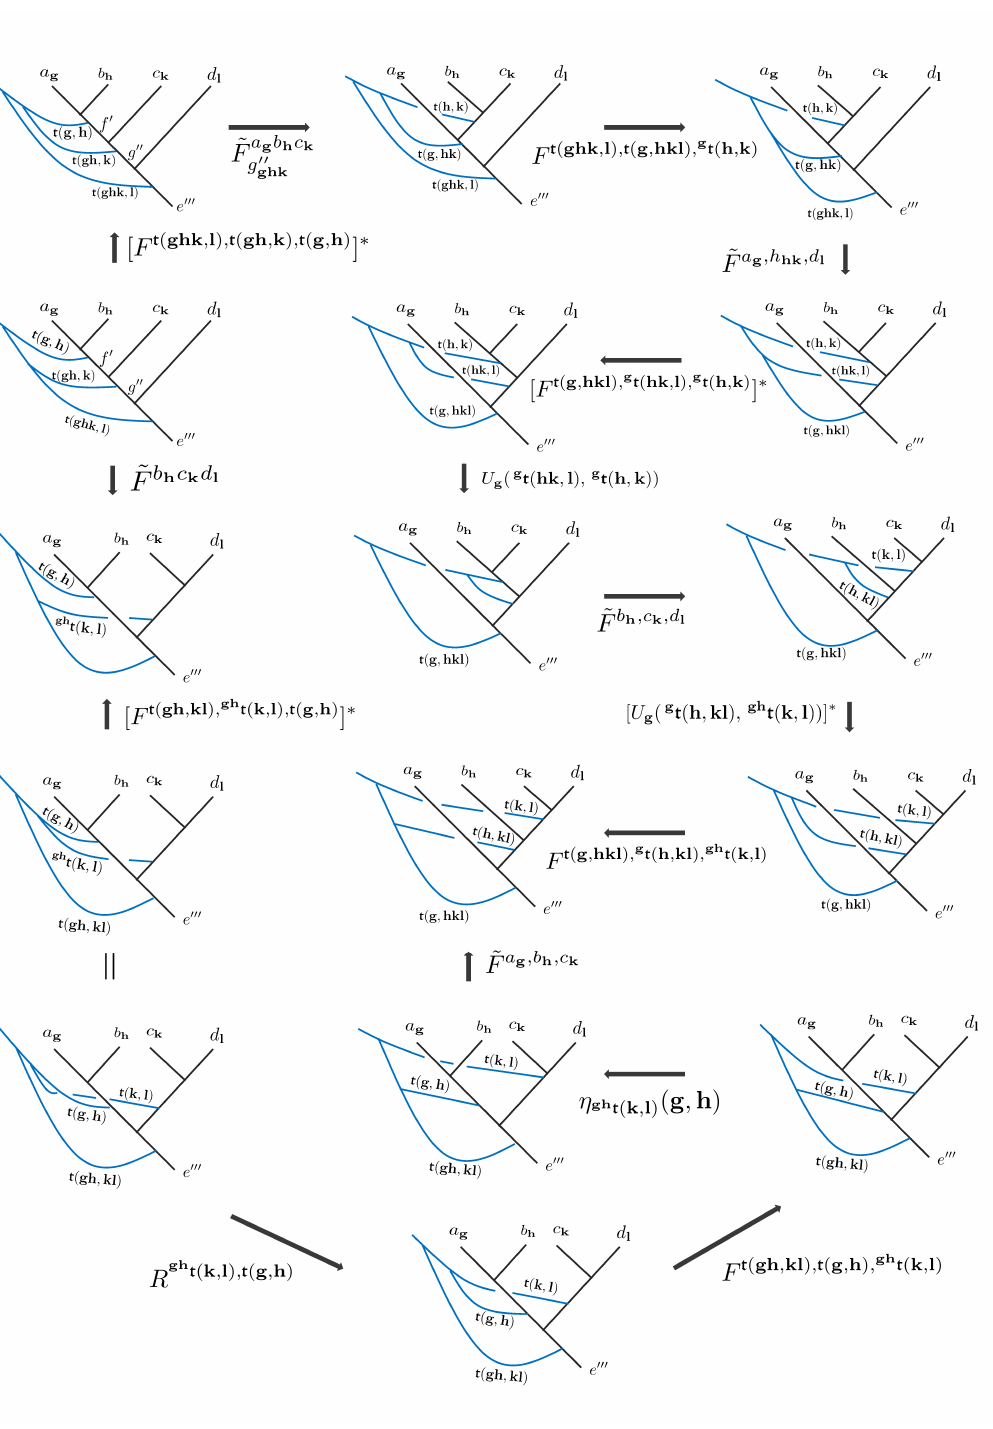
Figure 8: Consistency condition for derivation of relative anomaly. Anyon and defect lines are assumed to have arrows directed